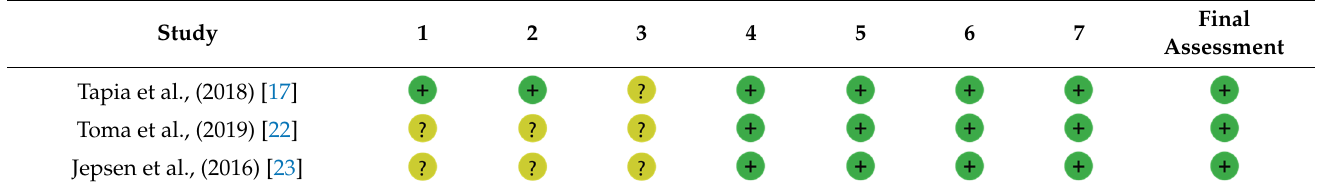
Table 4. Assessing the risk of bias of randomized trials using the Cochrane tool.